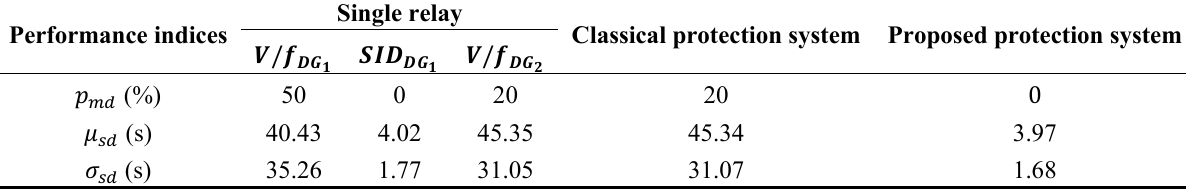
Table 7. Comparison between the classical and the proposed protection systems in the Case A. Performance indices